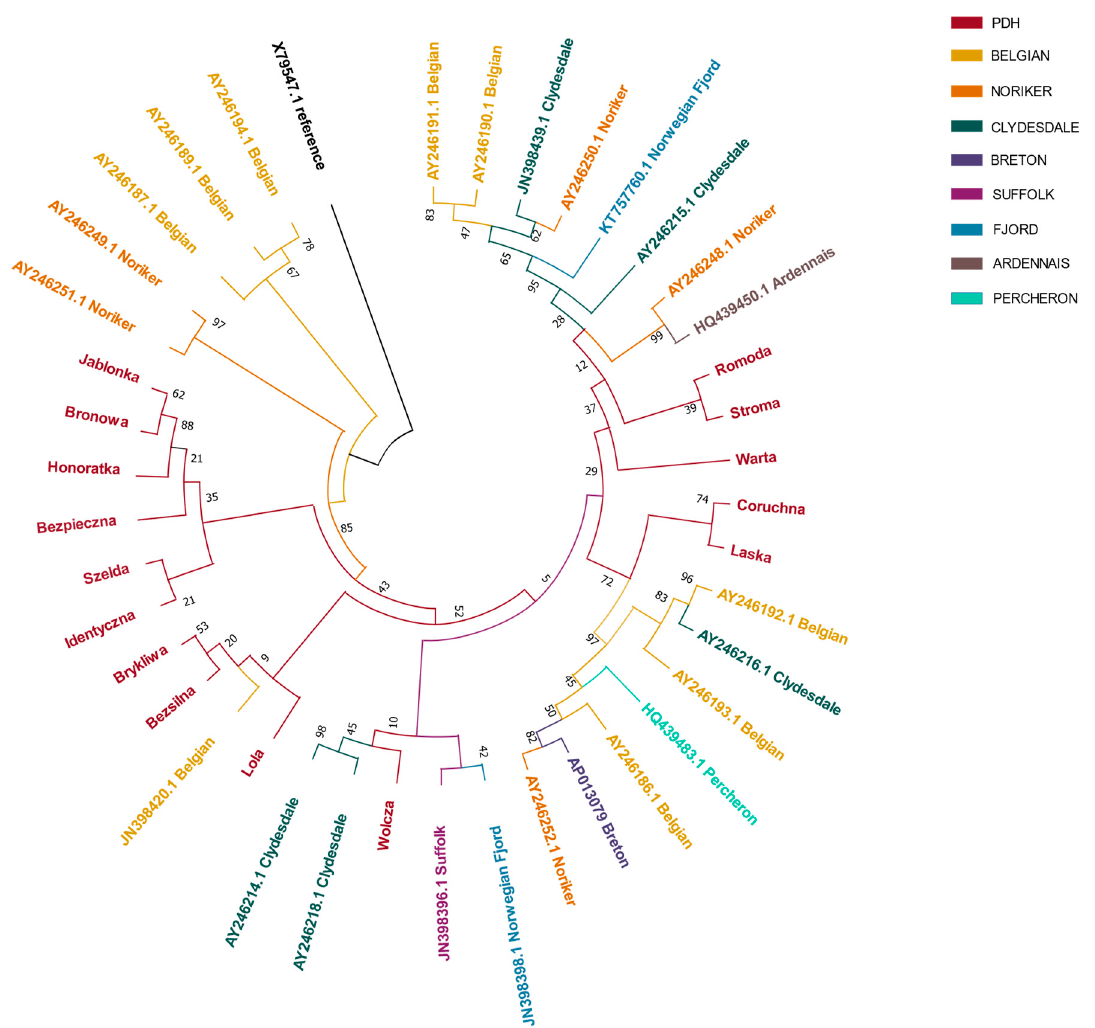
Figure 1. A neighbor ‐ joining tree for Polish Draft Horses and related cold ‐ blooded breeds. The GenBank X79547.1 reference sequence is used as a root of the tree. Each breed is represented by a different color.